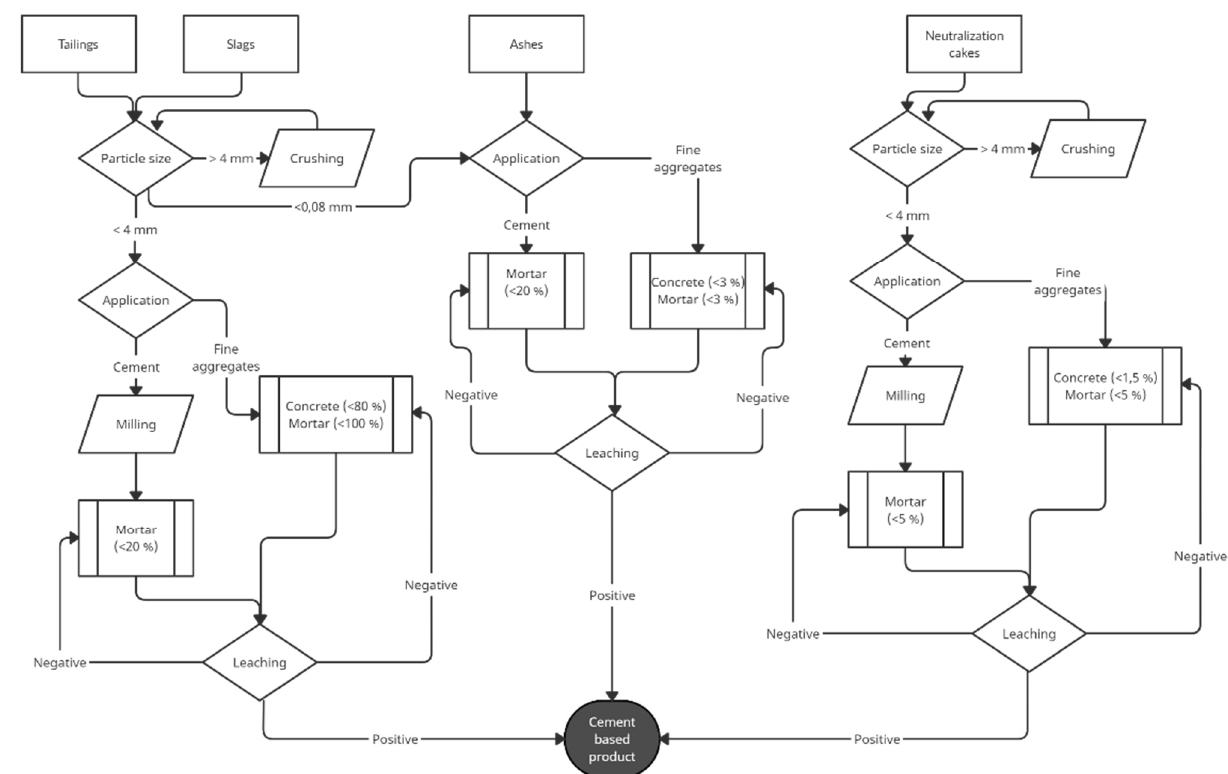
Figure 3. Decision tree for the use of copper residues in cement-based materials.